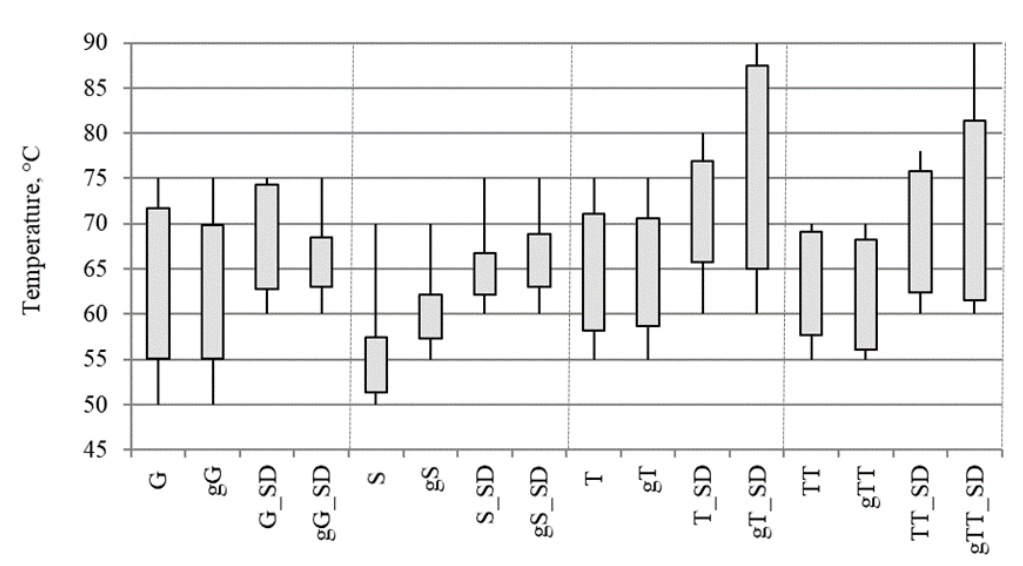
Figure 3. Temperature domains corresponding to the gelling process for the studied suspensions and sourdoughs during the temperature ramp test. The analysed temperature ranges corresponding to the inflection area of G’ vs. t curves are represented with lines, whereas the estimated gelling temperature domains are indicated as columns. Tests were performed on suspensions prepared using flours from raw (G, T, S and TT) or germinated grains (gG, gT, gS and gTT) and on corresponding sourdough samples (G_SD, T_SD, S_SD and TT_SD prepared out of G, T, S and TT flours, and gG_SD, gT_SD, gS_SD and gTT_SD prepared out of gG, gT, gS and gTT flours).